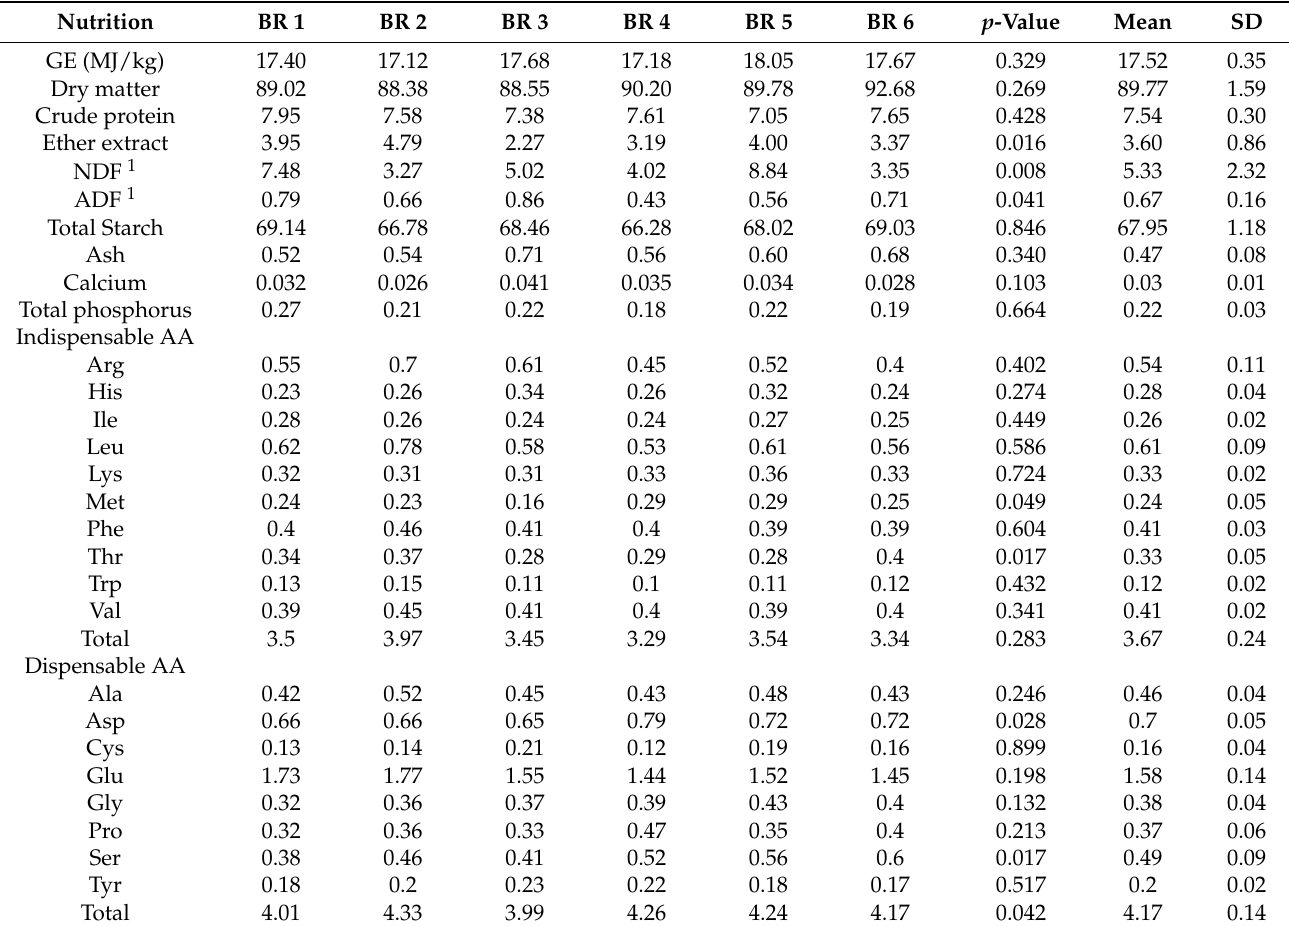
Table 3. Analyzed nutrition and amino acid composition of different sources BR